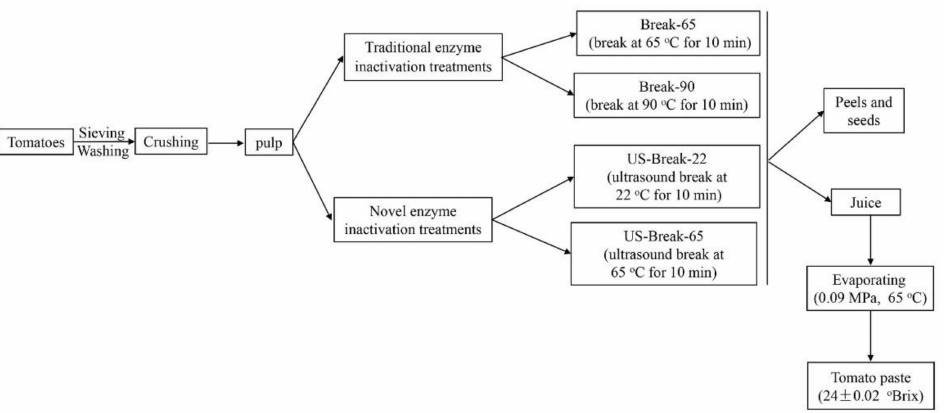
Figure 1. Tomato pastes production scheme. The treatment at 65 ◦ C for 10 min was defined as Break-65. The treatment at 90 ◦ C for 10 min was defined as Break-90. The ultrasound treatment of 87.52 W/cm 2 at 22 ◦ C for 10 min was defined as US-Break-22. The ultrasound treatments of 87.52 W/cm 2 at 65 ◦ C for 10 min was defined as